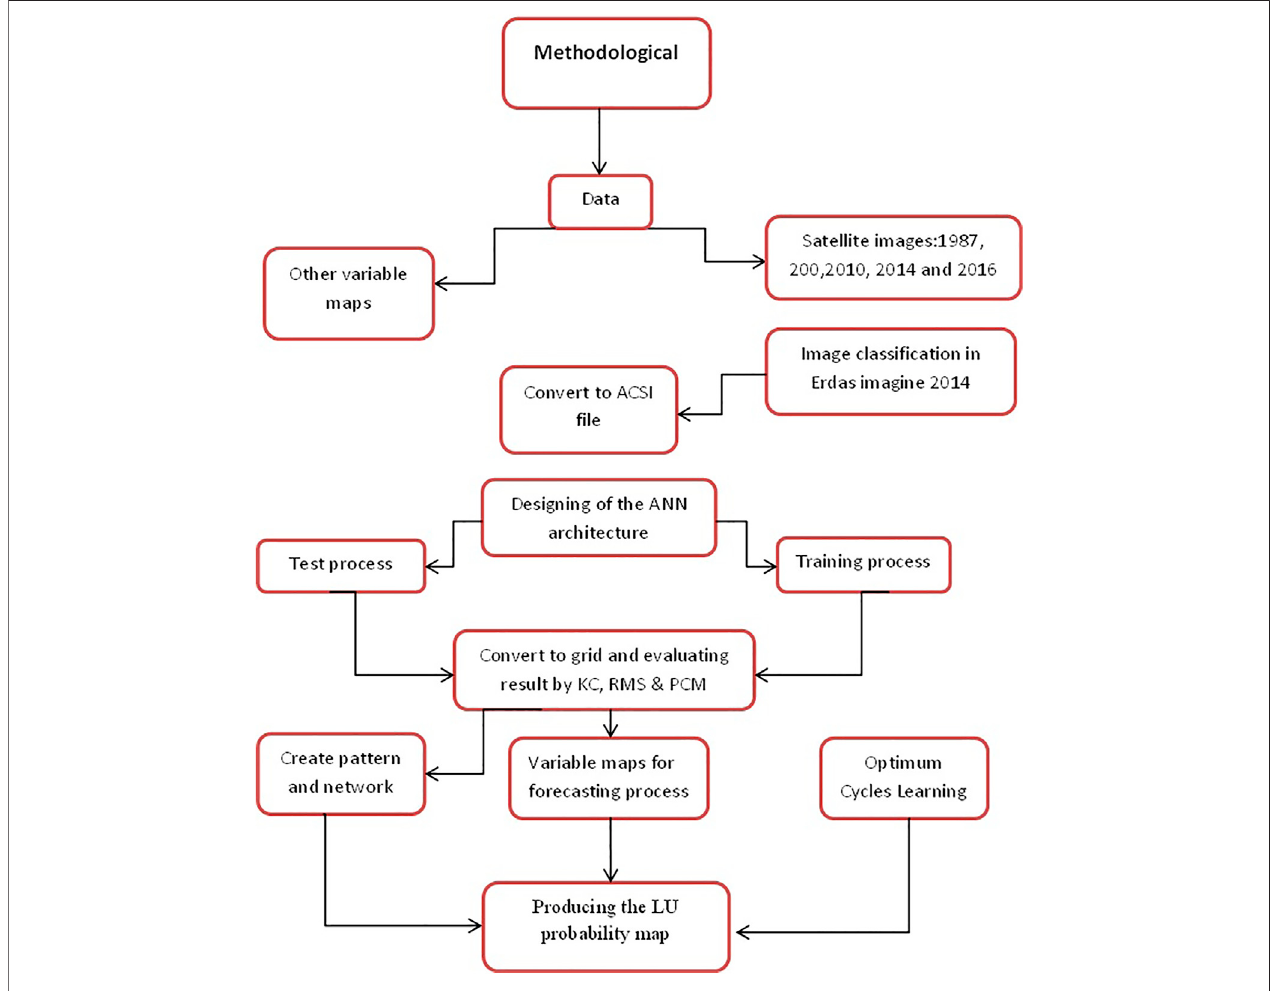
FIGURE 2 | Methodology process in LU probability land use